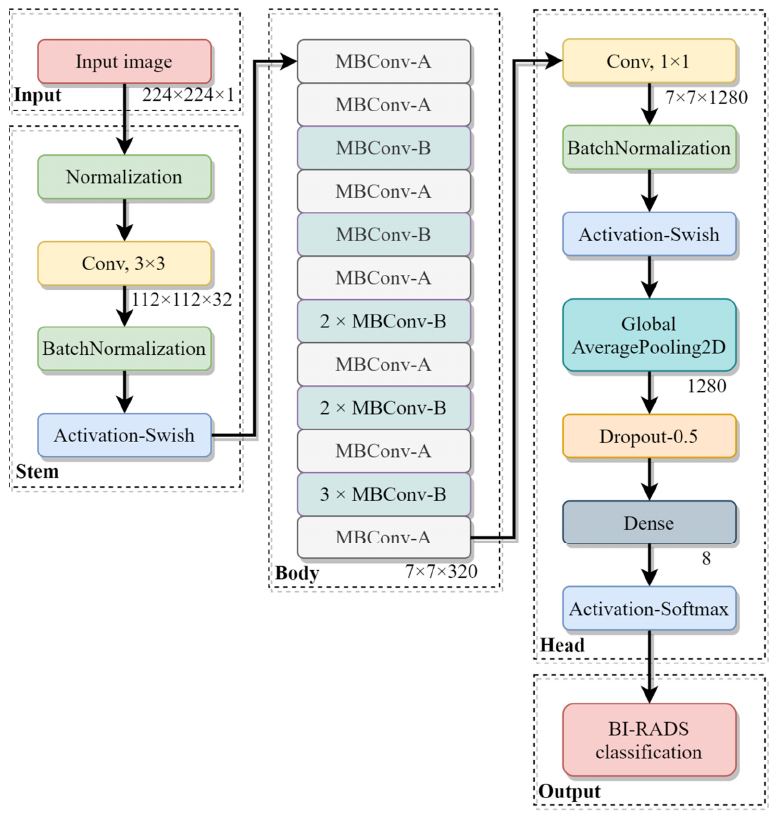
Figure 5. Flowchart of the presented BI-RADS classification model.